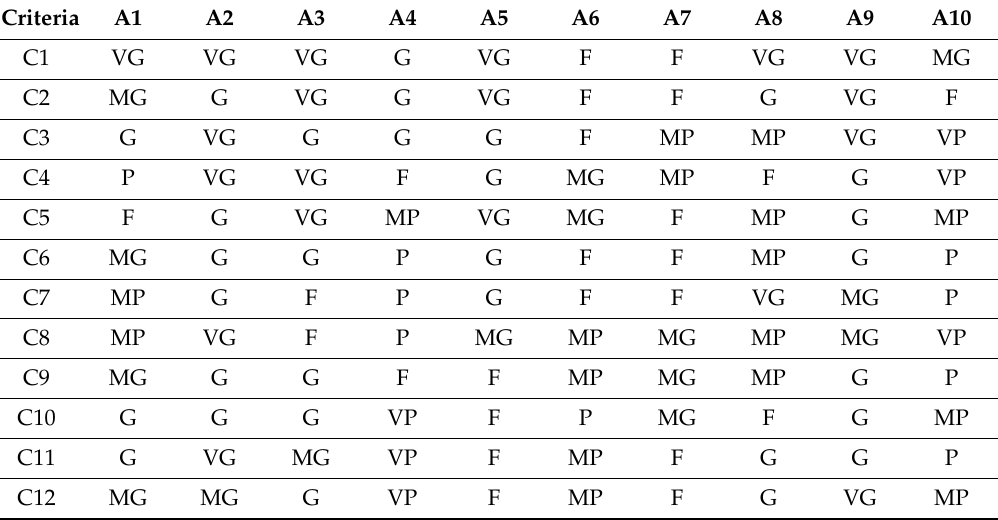
Table 8. Decision maker 3 (DM3) evaluates the